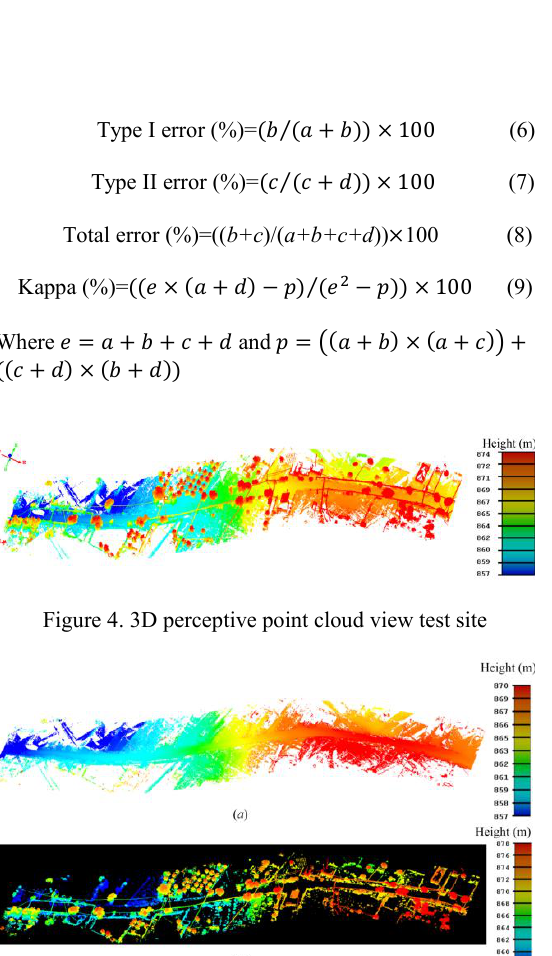
Figure 5. 3D perceptive point cloud view of (a) ground points (b) non-ground points, of test